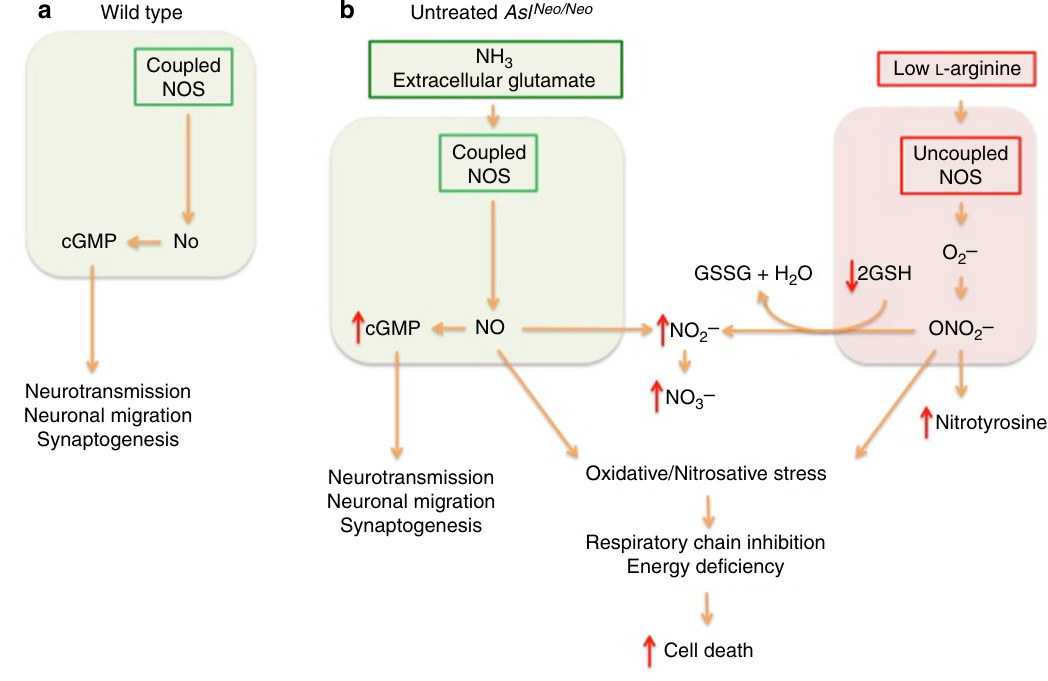
Fig. 7 Proposed pathophysiological mechanisms of the brain disease in Asl Neo/Neo mice. a Residual coupled NOS produces NO with increased cGMP production. b Low L -arginine causes NOS uncoupling and produces superoxide ions (O 2 − ), which will generate the production of peroxynitrite (ONOO − ). ONOO − causes oxidative/nitrosative stress with production of nitrotyrosine and nitrite (NO 2 − ) after detoxi fi cation of ONOO − by reduced glutathione (GSH). Oxidative/nitrosative stress will impair the respiratory chain, alter the energy production of the cell and lead to cell death. Neurons are particularly vulnerable as they cannot increase their production of glutathione adequately, and rely on an astrocytic supply. b Red arrows represent modi fi ed measured parameters in Asl Neo/Neo compared to WT mice. This fi gure relies on data provided in this study and in the literature 13,18,21,25,27 and discussed in the manuscript. cGMP cyclic guanosine monophosphate, GSH reduced glutathione, GSSG oxidised glutathione, NO nitric oxide, NO 2 − superoxide ion, ONO 2